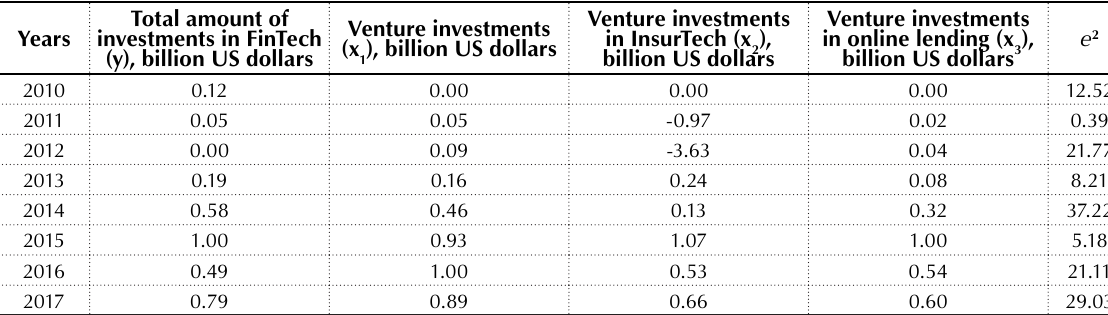
Table 5. Output data for calculating the Breusch-Pagan test Total amount of Years investments in